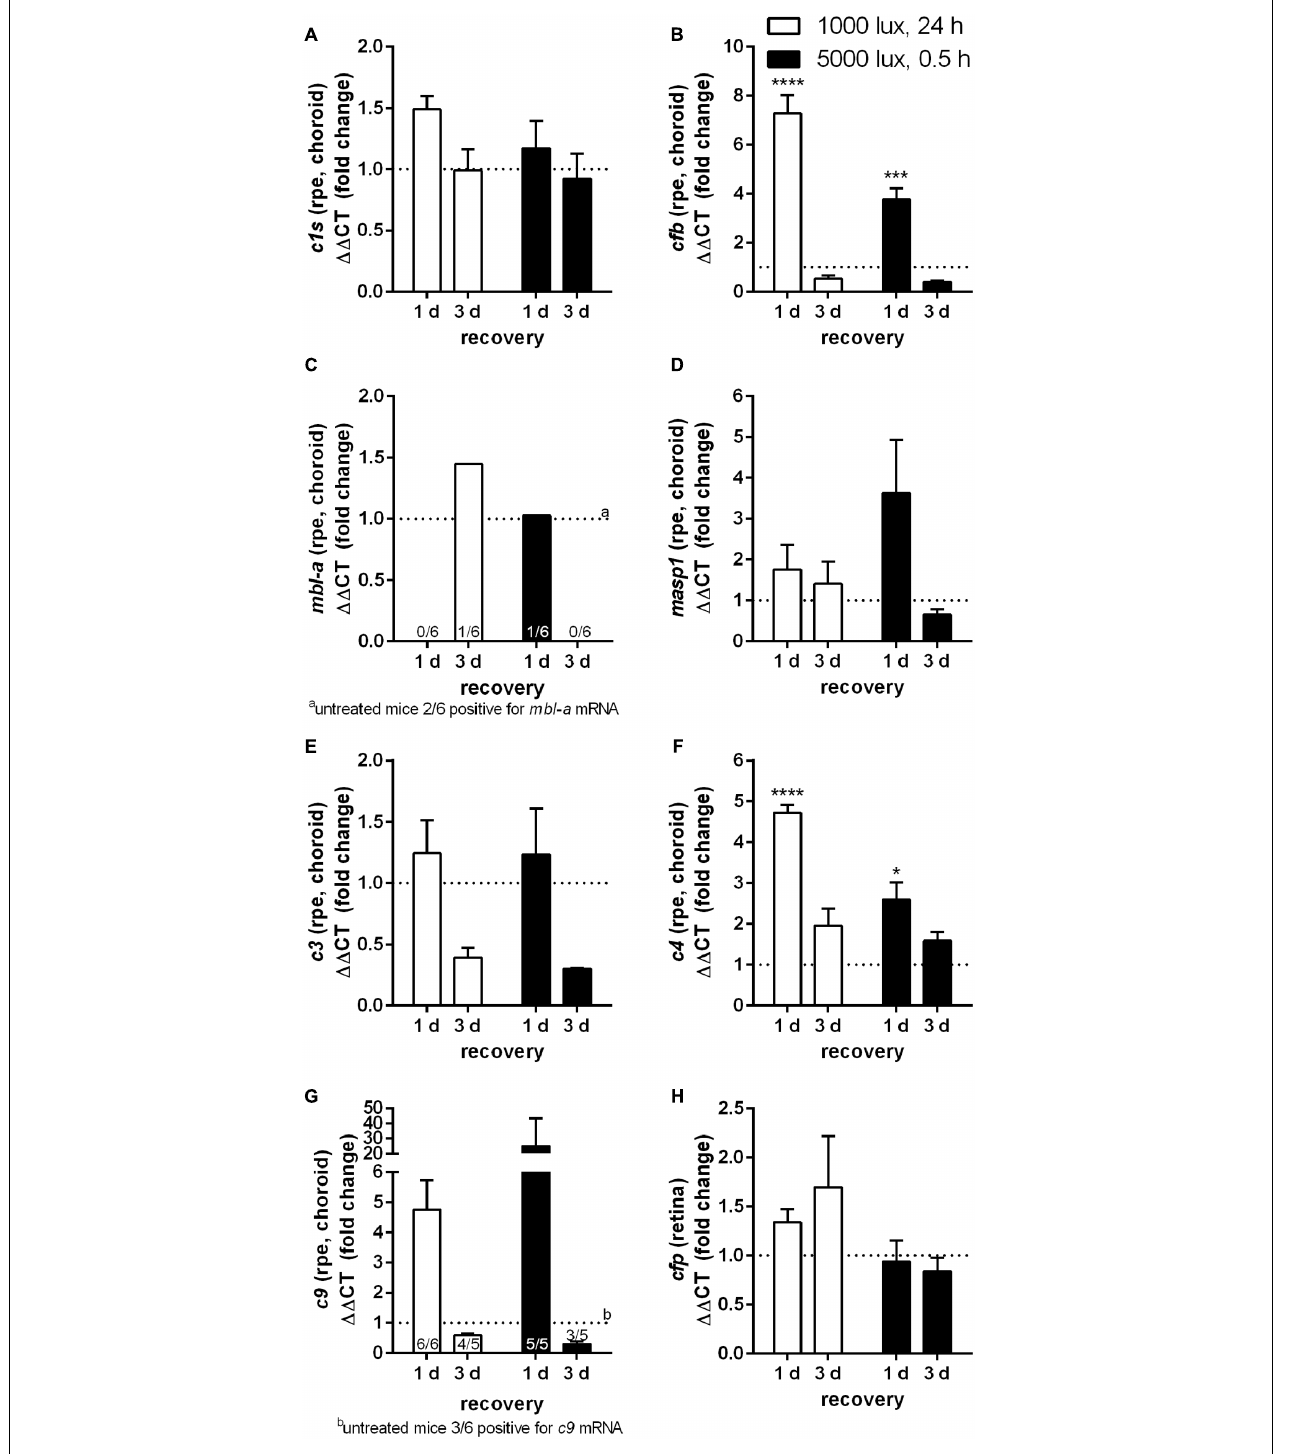
FIGURE 3 | mRNA expression of complement factors in the RPE/choroid-complex is increased at 1 day following constant and acute LD. mRNA expression was analyzed in the RPE/choroid of mice treated either with constant (1000 lux, 24 h; white bars) or acute white light (5000 lux, 0.5 h; black bars) and compared to untreated controls. (A) c1s , (B) cfb , (C) mbl-a , (D) masp-1 , (E) c3 , (F) c4 , (G) c9, and (H) cfp mRNA was determined. (A) C1s , (B) cfb , (E) c3 , (F) c4, and (G) c9 mRNA was elevated at 1 day post-light treatment. mRNA expression decreased 3 days following LD. (C) mbl-a and (G) c9 mRNA was partly detected. Positive animals were indicated as small numbers in the bars. Data represent mean values + standard error of the mean. Mean of untreated control shown as dotted line. ∗ 0.01 < P < 0.05, ∗∗∗ 0.0001 < P < 0.001, ∗∗∗∗ P < 0.0001 (ordinary one-way ANOVA, Dunnett’s multiple comparisons test, with a single pooled variance).